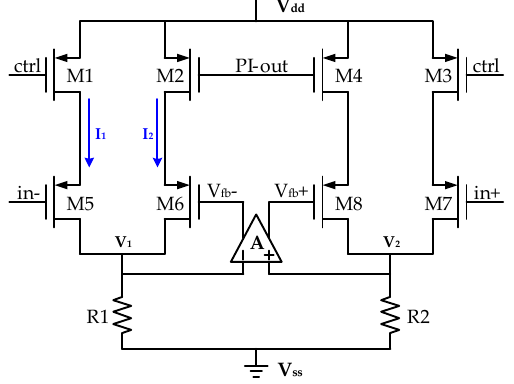
Figure 6. Schematic of the proposed nonlinear multiplier.